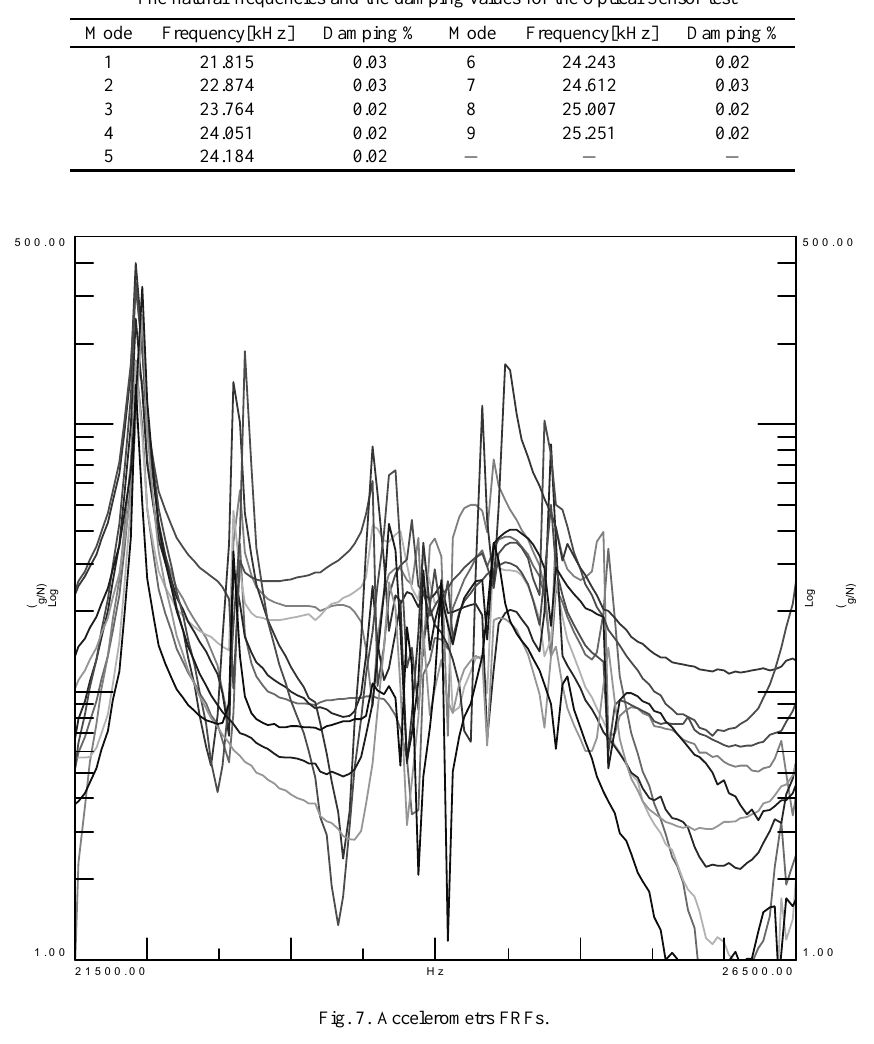
Table 3 The natural frequencies and the damping values for the Optical Sensor test